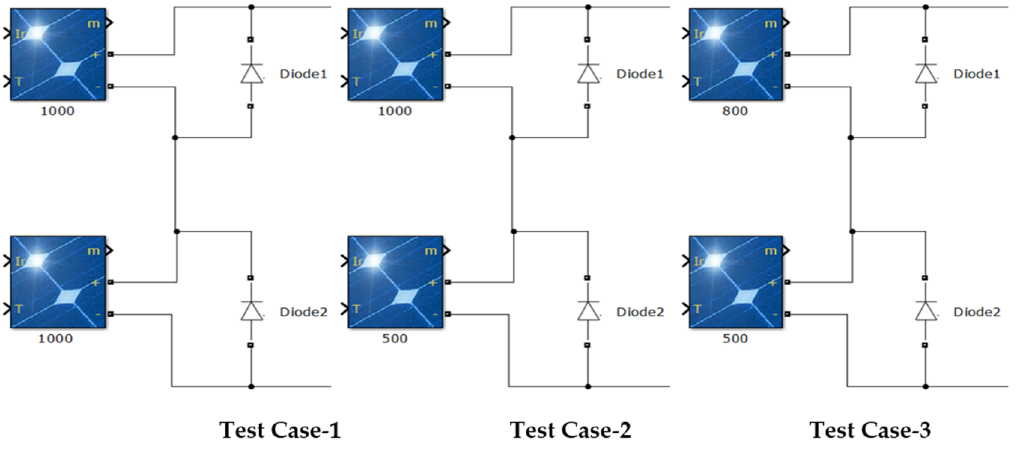
Figure 30. Test cases for 2S PV system.